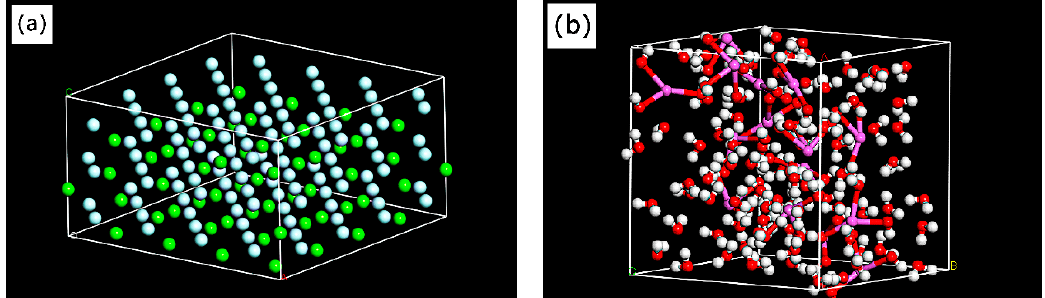
Figure 4. Model: ( a ) the model of CaF 2 surface; ( b ) the model of an aqueous solution containing Al(OH) 3 molecules.